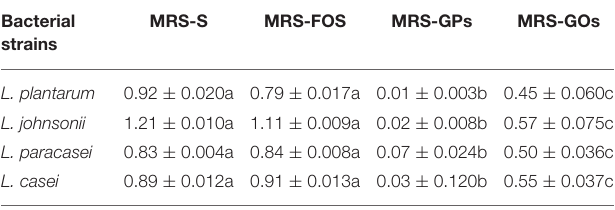
TABLE 2 | PI value of the medium at 48h. Bacterial